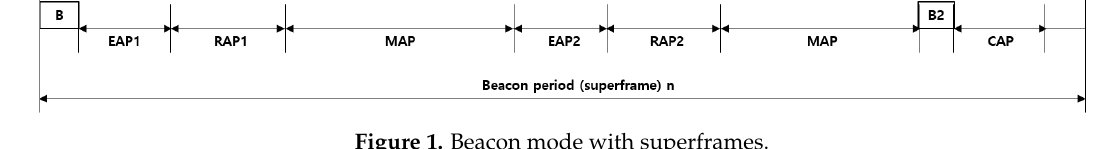
Figure 1. Beacon mode with superframes.